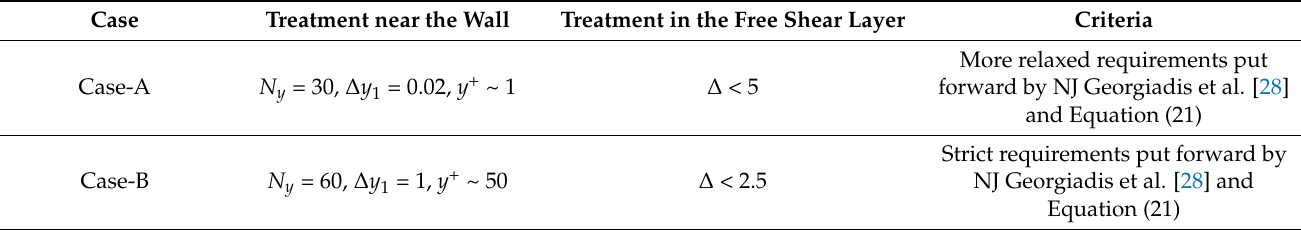
Figure 3. Computational grids on pipe cross sections in the LES portion: ( a ) Case-A with approxi- mately 0.5 million cells; ( b ) Case-B with approximately 1.6 million cells; ( c ) Case-C with approximately 4.0 million cells; ( d ) Case-D with approximately 6.4 million cells. Table 2. Information for grid